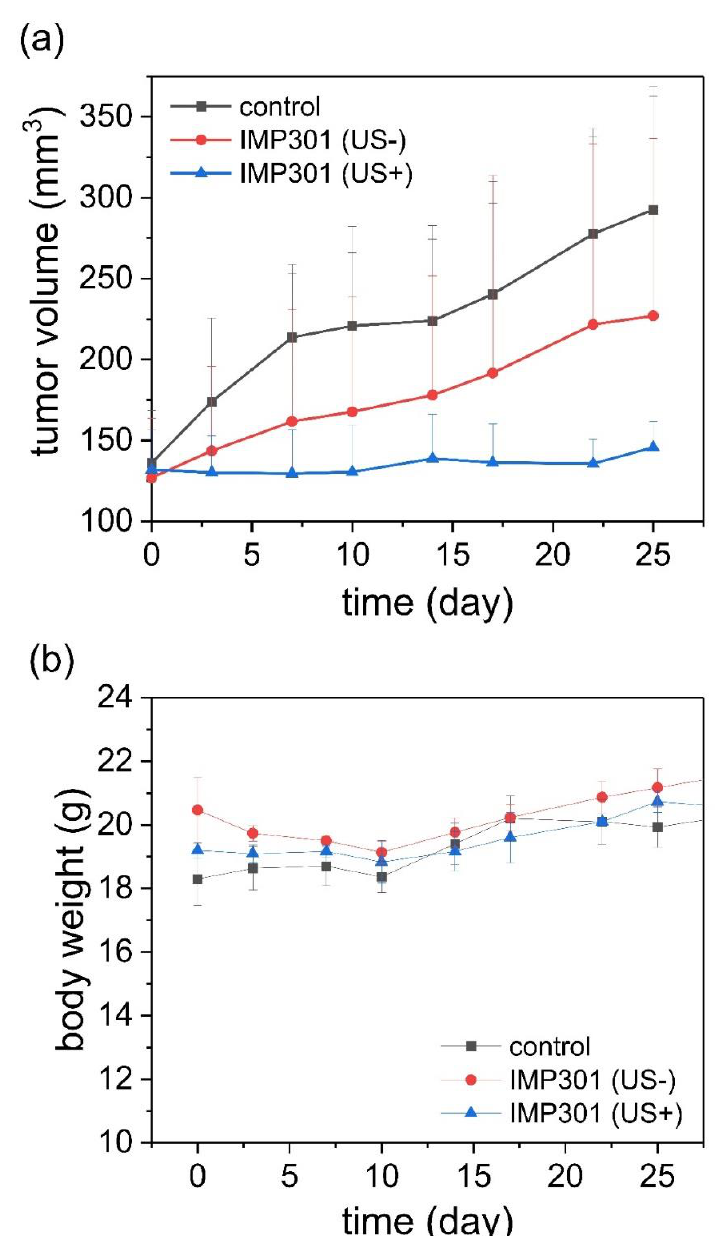
Figure 8. In vivo therapeutic efficacy of the combination of IMP301 and ultrasound in MDA-MB- 231 mice after three rounds of treatment. ( a ) Tumor growth in MDA-MB-231 tumor-bearing mice intravenously administrated with saline (control; black line), IMP301 (IMP301 US-; red line), and IMP301 with FUS irradiation (IMP301 US+; blue line). ( b ) Body weight change of mice in each group; ( n = 3).